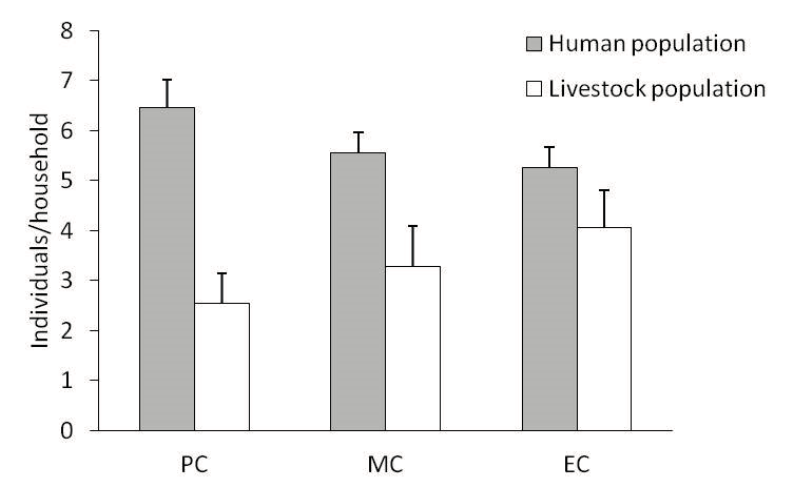
Figure 8. Mean (± se) number of human and livestock population per household between three corridors of BRT. ( n = 31, 39 and 30 households from Punajanur corridor (PC), Mudalli corridor (MC) and Edeyarahalli corridor (EC),